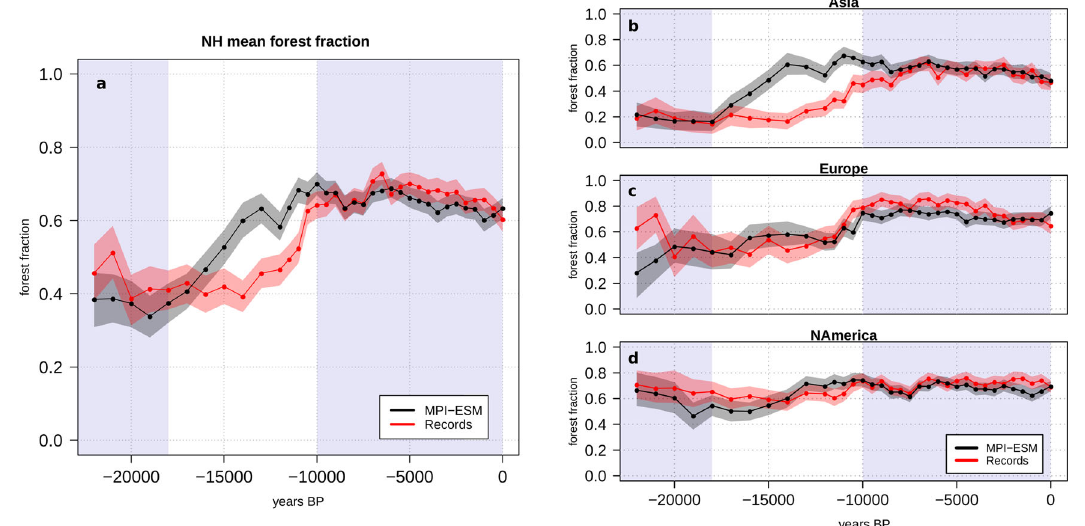
Fig. 2 | Change in NH forest coverage. Simulated (black) and reconstructed (red) forest cover and its uncertainty (black and red shadings) on the Northern Hemi- sphere (NH) and for individual continents, based on grid-cells. For this, the record andmodelsampleshavebeenaggregatedintoaregularlongitude-latitudegrid(10°